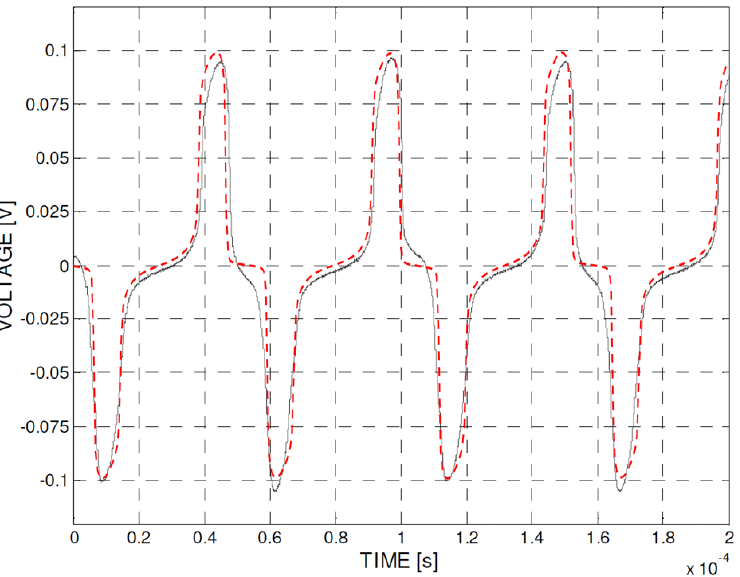
Figure 11. Calculated differential output voltage with 150 µ T external field (dashed-dotted red line) overlapped with the experimental results from Figure 13 in [33] (Copyright 2022 IEEE Transactions on Instrumentation and Measurement) obtained in the same